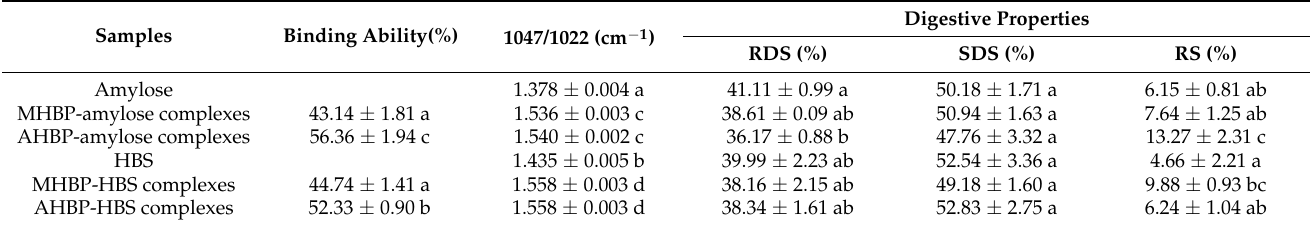
Table 2. Binding ability, 1047/1022 ratio, and digestive properties of highland barley polyphenol- starch complex extracted with different